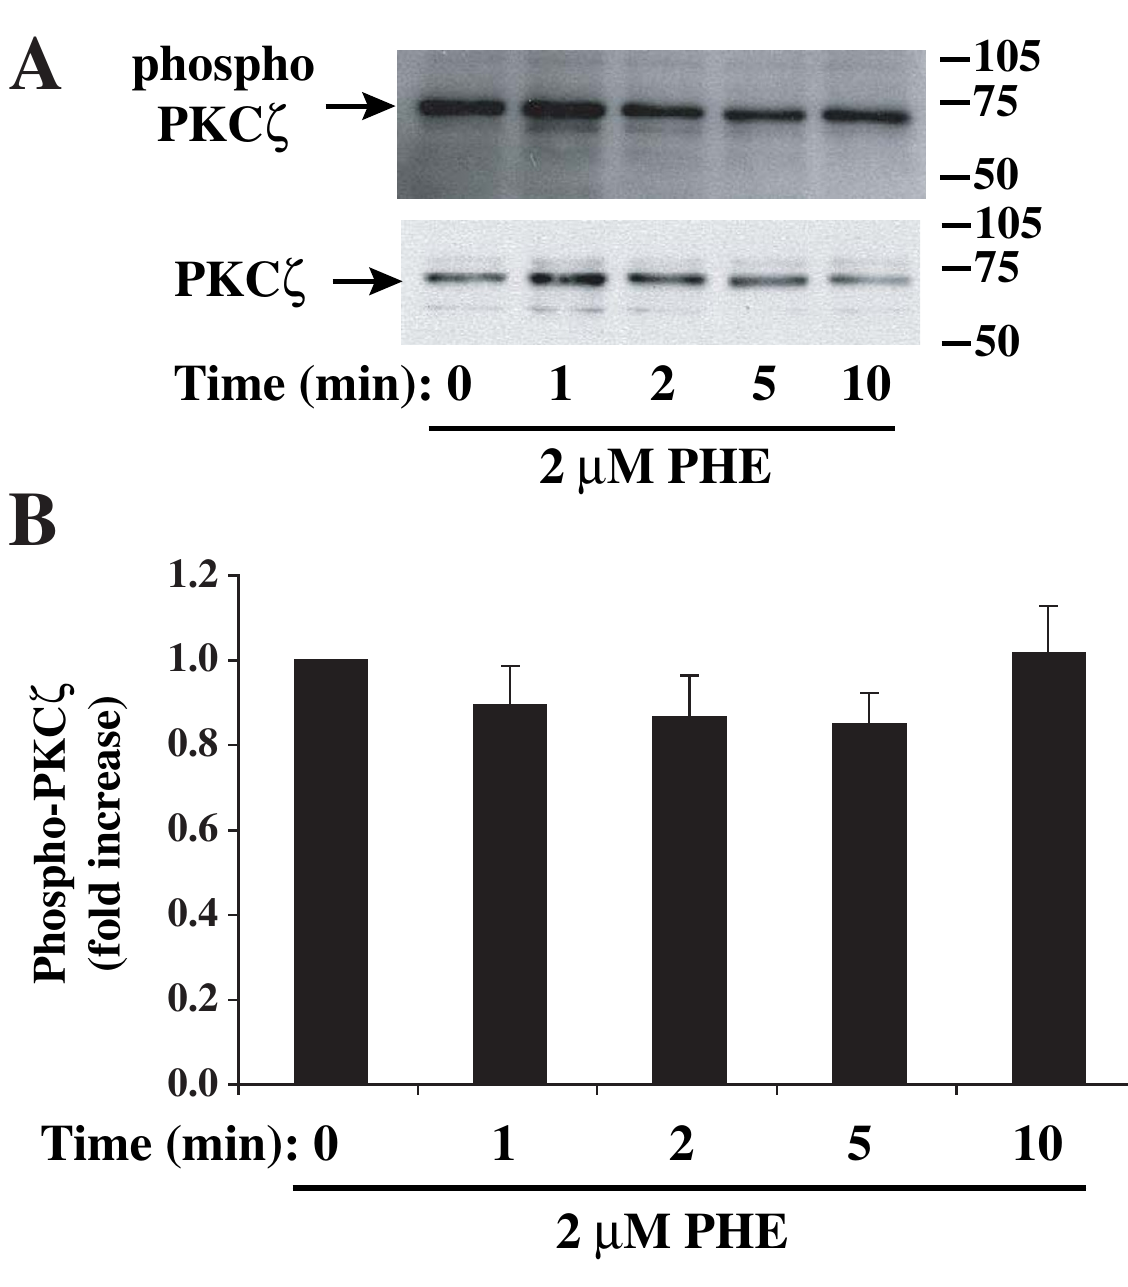
Figure 4 Effect of PHE on PKC ζ phosphorylation at Thr 410. Cells were arrested for 48 hours and incubated for different time with 2 µ M PHE. Samples were prepared for Western blot analysis and incubated with a phospho-PKC ζ / (Thr 410/403) anti-